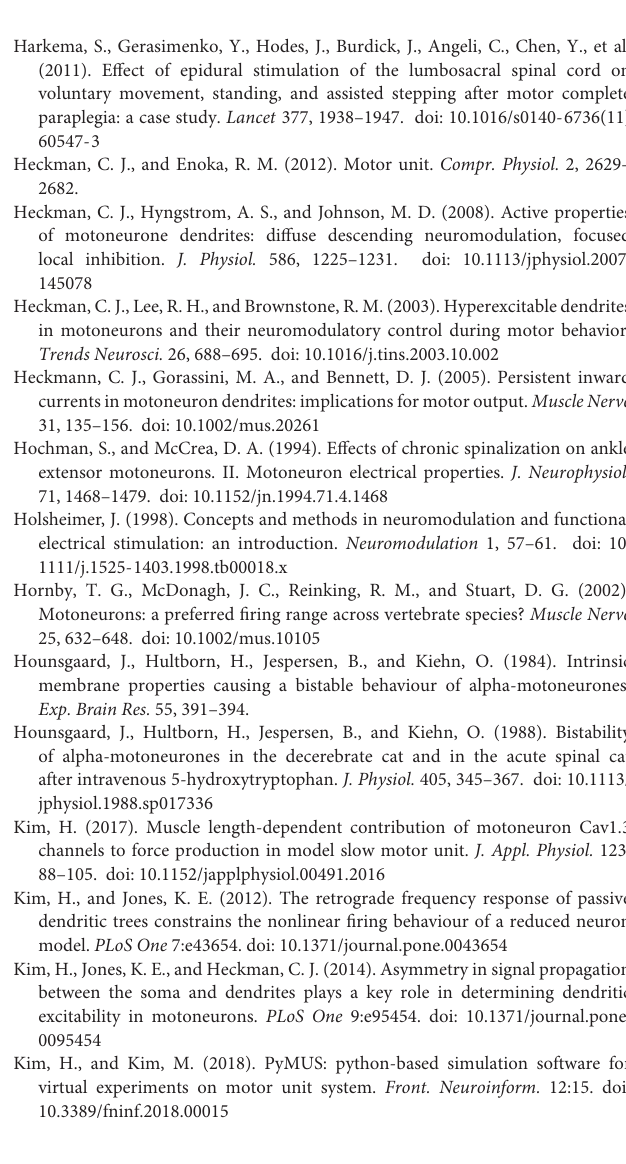
Supplementary File 1 | Equations and descriptions of the model motor unit. Supplementary File 2 | Computer codes of the models and simulations. Supplementary File 3 | Dataset of the current stimulation levels applied to the motoneuron for force production of the muscle unit at the various speeds and levels, as shown in Figures 3–7